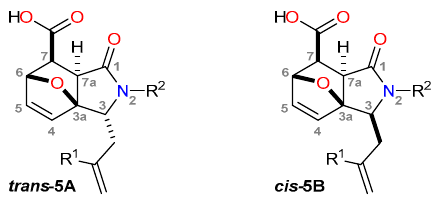
Figure 2. Structures of the cis and trans diastereoisomers of 3a,6-epoxyisoindole-7-carboxylic acids 5.